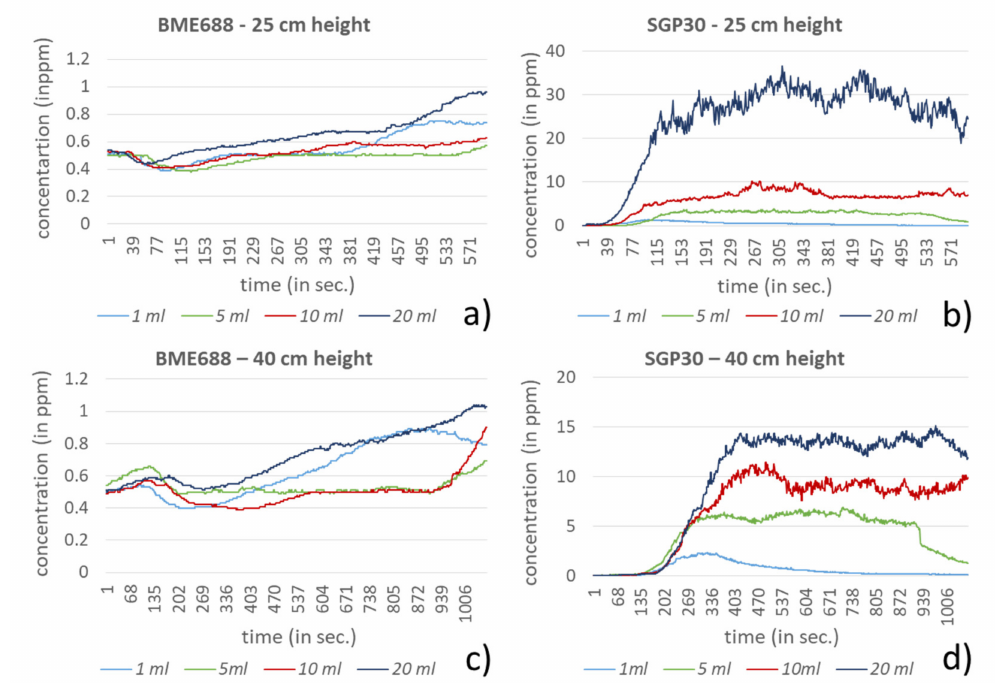
Figure 13. Response of BME688 and SGP30 for different amounts of acetonitrile and for 25 and 40 cm height above the emission source. In ( a ) a measurement height of 25 cm for BME688 and ( b ) for SGP30 is used. In ( c ) the measurement height was changed to 40 cm for BME688 and ( d ) for